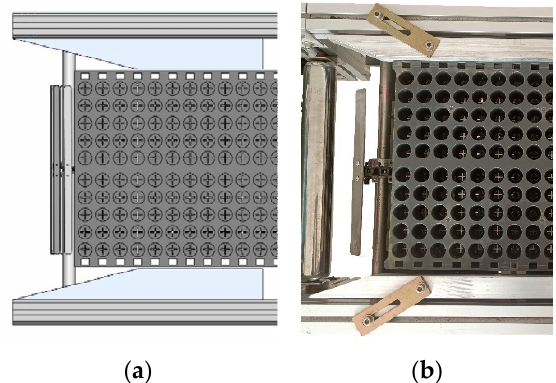
Figure 8. Tray positioning baffle. ( a ) 3D diagram. ( b ) Object diagram.